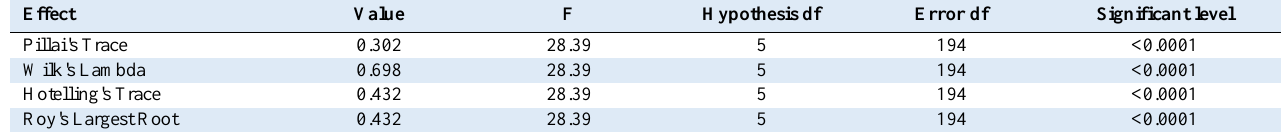
Table 3. Results achieved from MANOVA analysis on the mean of general health and life expectancy scores between students with favorable and unfavorable Effect